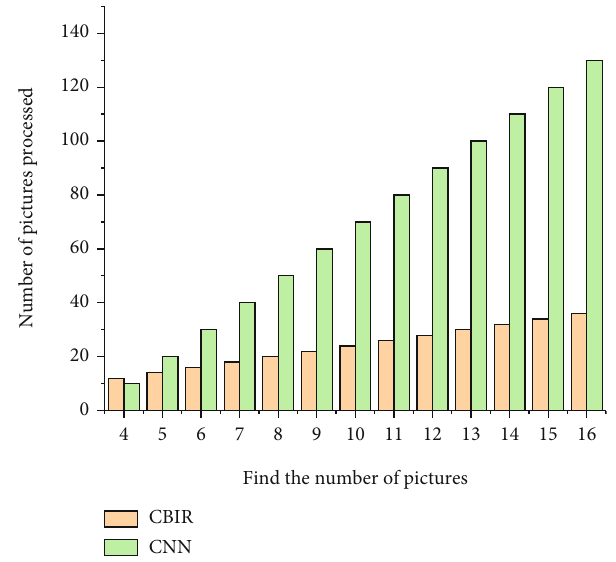
Figure 5: Comparison of e ffi ciency after algorithm improvement.